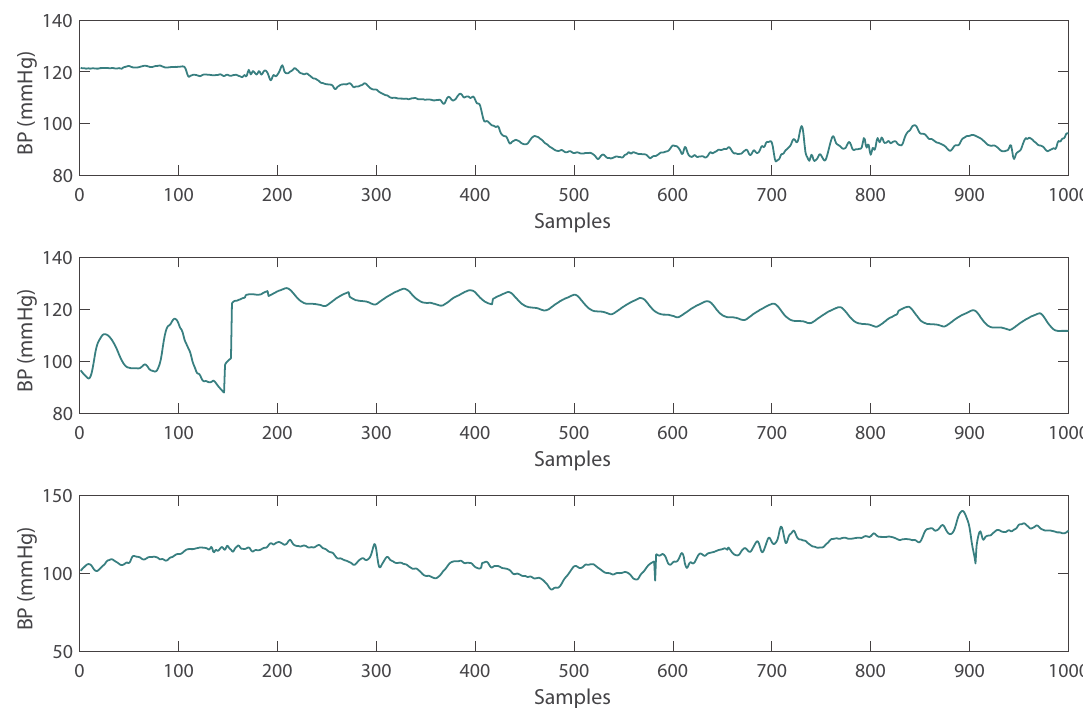
Figure 2. Abnormal BP signals with irregular